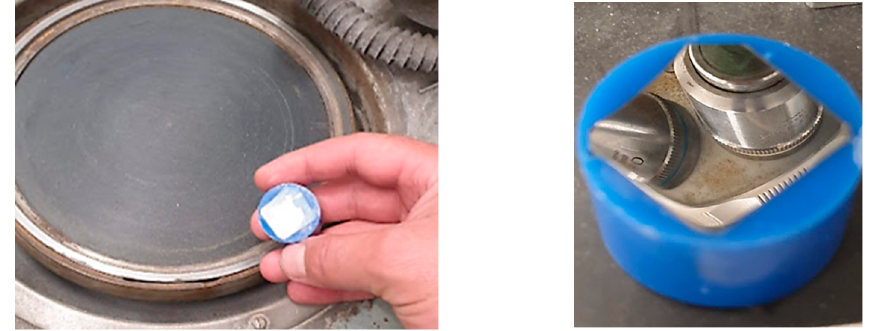
Figure 19. Preparation for resin incorporation. Preparation for resin embedding (Figure 18). Embedding in resin and grinding/polishing (Figure 20).